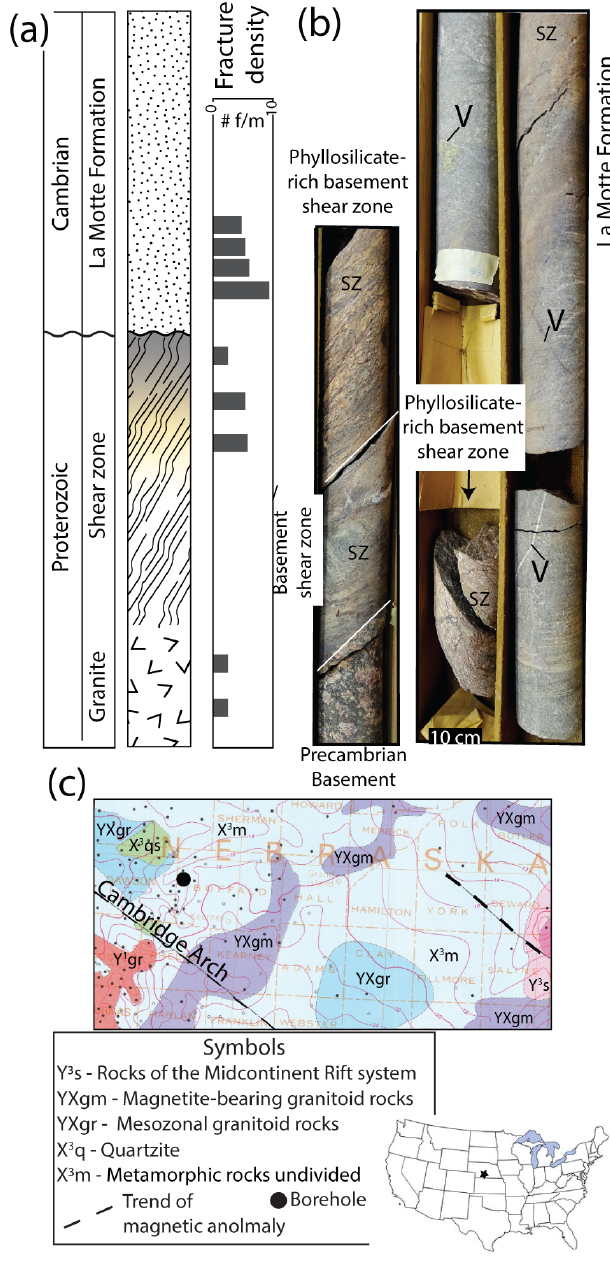
Figure 4. (a) Lithologic log of the R.C. Taylor 1 core, Nebraska, from 3984 to 4038ft (1214–1231m) of measured depth. The non- conformity occurs at 4018ft (1225m). Fracture density in the core is based on the number of fractures per meter of core. Four lithologic units are identified in the core, including sandstone, sedimentary-rock-hosted shear zone, altered basement shear zone, and minimally altered basement. The nonconformity occurs be- tween the altered basement shear zone and overlying sandstone of the La Motte Formation. (b) Photographs of the R.C. Taylor 1 core. Both the basement shear zone (SZ) and overlying sandstone are cut by veins (V) of quartz, calcite, and Fe-oxides. (c) The borehole loca- tion is shown on the Precambrian basement map from Sims (1985).